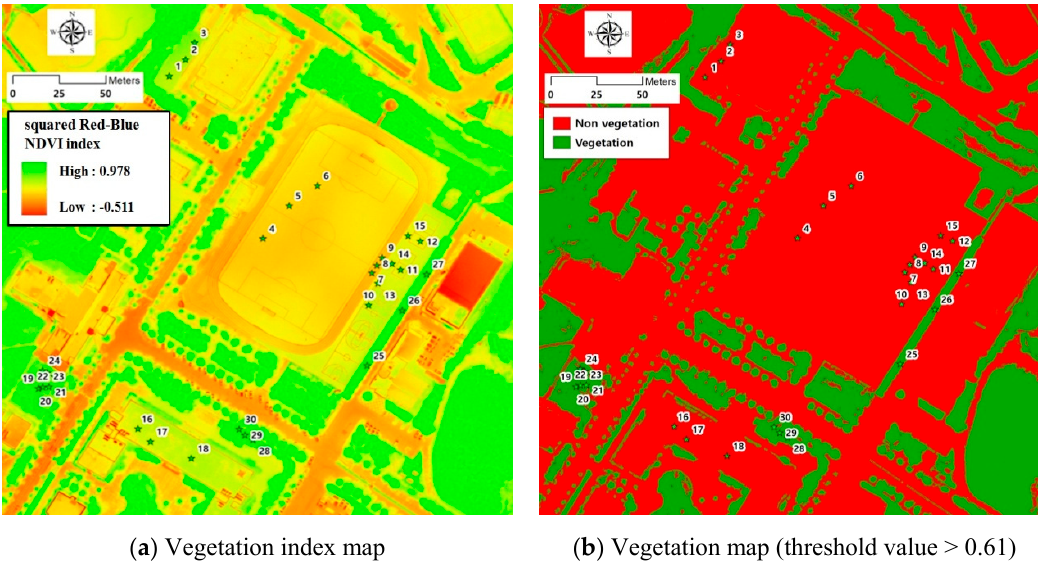
Figure 10. Vegetation index map and vegetation map based on the squared Red-Blue NDVI index.